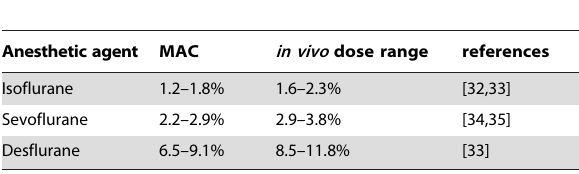
Table 1. Physiological anesthetic ranges for volatile anesthetics.